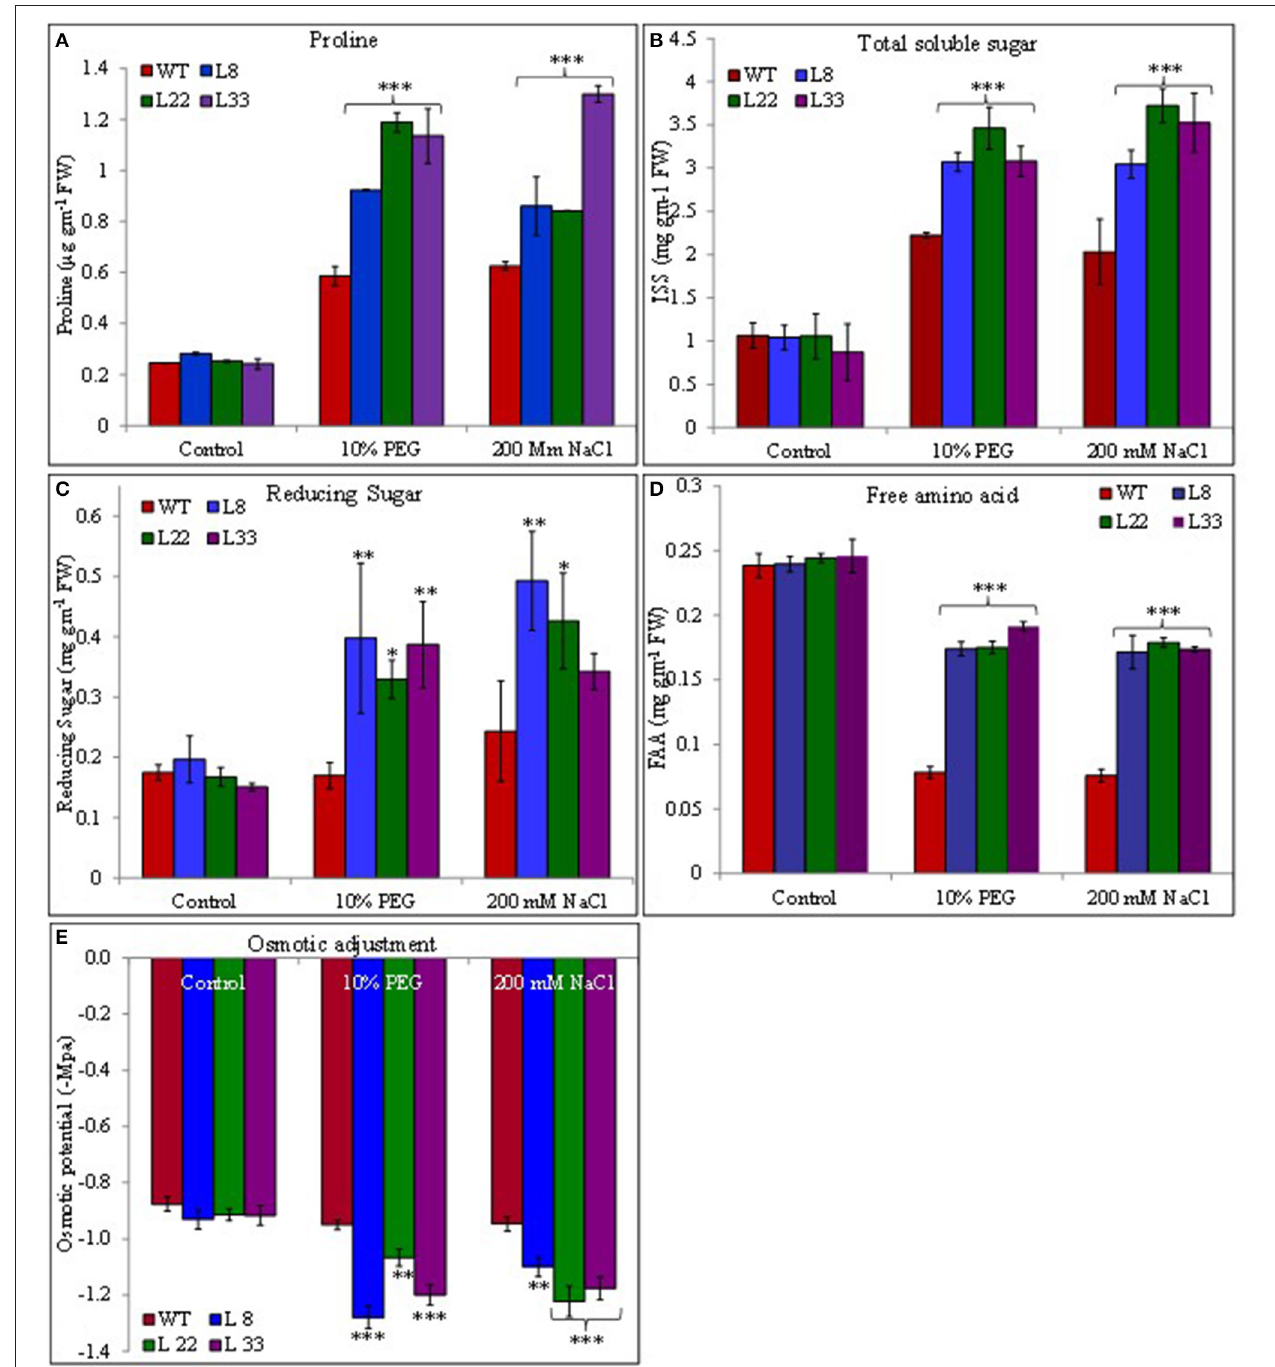
FIGURE 10 | Comparison of proline (A) , total soluble sugar (B) , reducing sugar (C) , free amino acid (D) contents, and osmotic potential (E) in WT and transgenic tobacco under control and stress (drought and salt) conditions. The *, **, and *** denote statistical significance in responses of transgenic lines against control at P value ≤ 0.05, 0.01, and 0.001